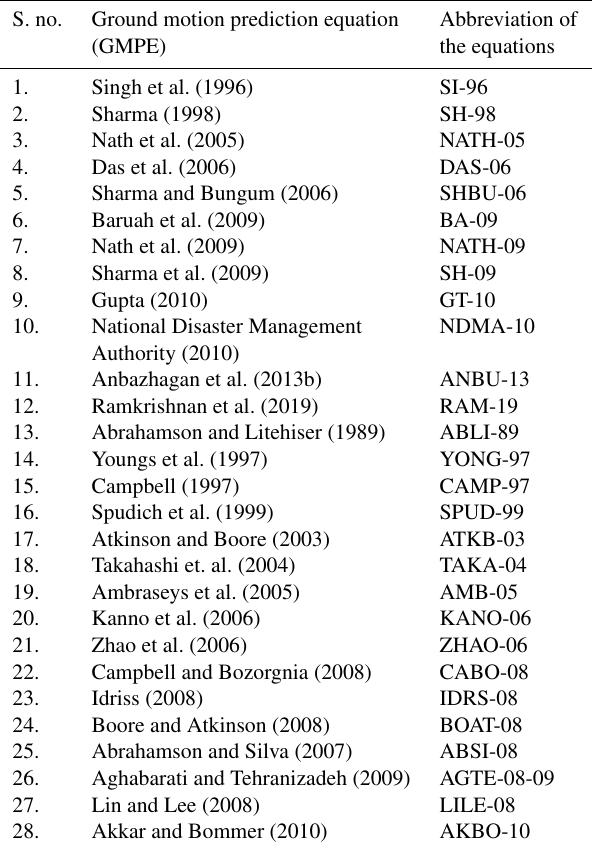
Table 2. Available GMPEs with their Abbreviations considered for the seismic study